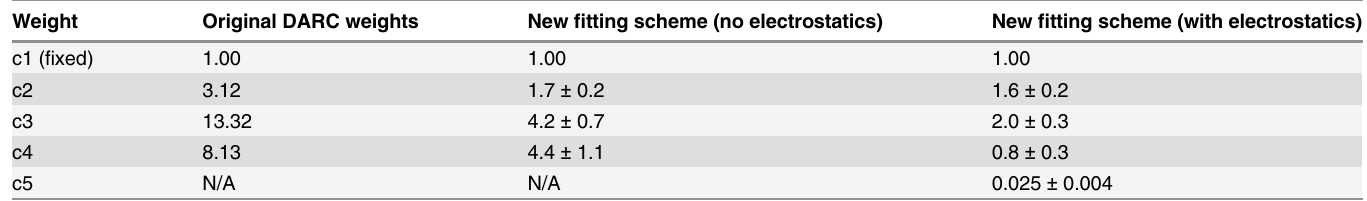
Table 1. DARC weights obtained via different approaches. The first four parameters (c1/c2/c3/c4) refer to those used by DARC to evaluate shape com- plementarity (Eq 1); the last parameter (c5) is used to scale the electrostatic term, when this term is used (Eq 4). The original DARC weights were obtained by minimizing the collective RMSD for docking a series of seven ligands to their cognate receptors [22]. We also report the weights that arise from our new weight fitting approach ( Enhancement #2 ), trained on all 25 proteins in our latest test set. Because this new approach is much faster, we were able to apply leave-one-out cross-validation to this set; here we also report the standard deviation observed among the weights trained on the 24-protein subsets. The magnitudes of the weights are not indicative of the relative importance of each term in the scoring function, since the magnitudes of the unscaled contributions vary broadly (e.g. the unscaled electrostatic term is typically much larger than the other terms, so a very small weight is needed to balance its contributions to the total